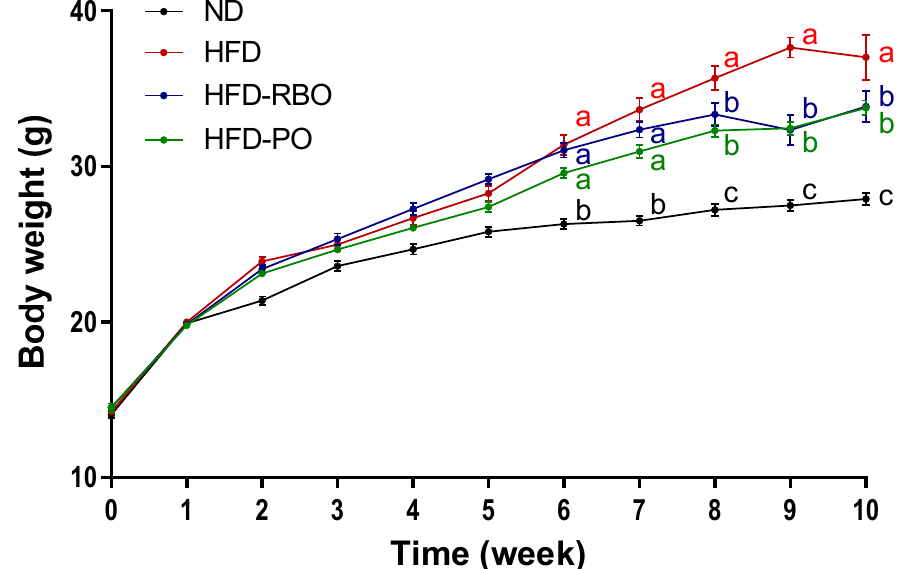
Figure 1. Body weight changes in C57BL/6 male mice who were allowed ad libitum access to the indicated diets as pellets for 10 weeks. Results are reported as means ± SEM. Mean values with different letters are significantly different within the specific week ( p < 0.05). (ND, normal diet; HFD, high fat diet; HFD-RBO, high-fat diet-rice bran oil; HFD-PO, high-fat diet-palm oil).